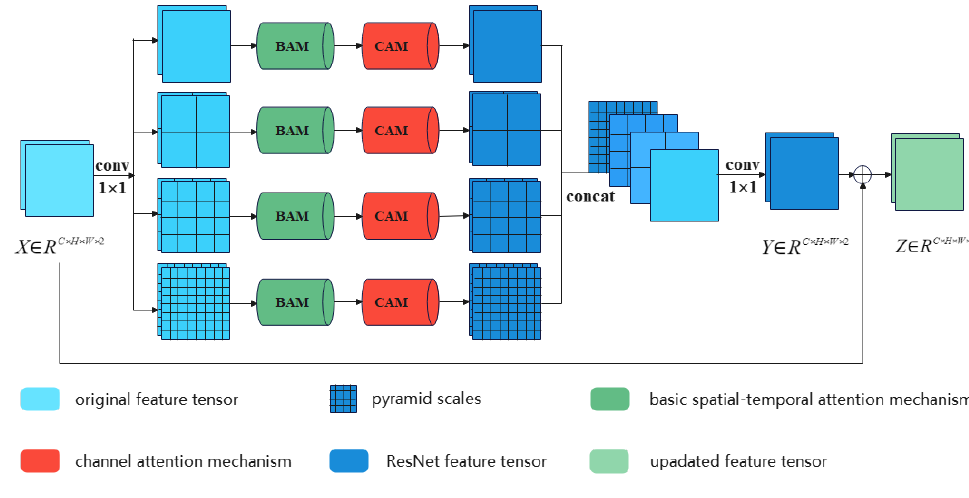
Figure 3. The structures of multi-attention.